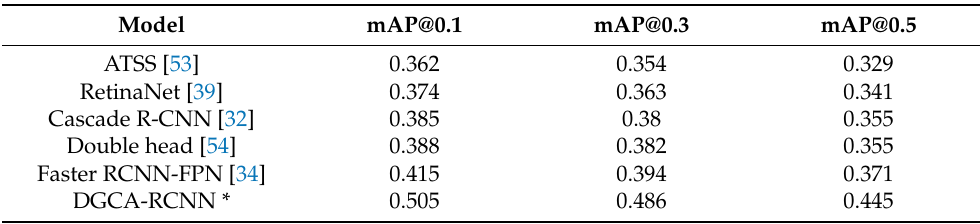
Table 4. Comparison of the mAP at three different IOU levels for the proposed DGCA-RCNN framework with other state-of the-art methods for object